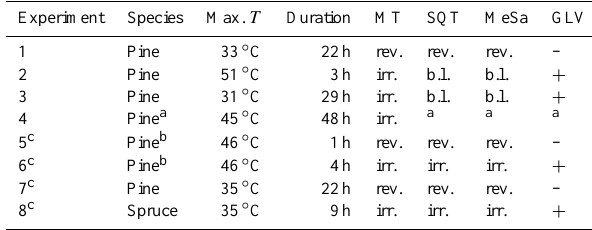
Table 3. List of experiments investigating impacts of heat on BVOC emissions from conifers and observed effects. “rev”: no irreversible effect observed. “irr”: irreversible effect observed with increases of pool MT emissions and decreases of SQT and MeSa emissions; “b.l.”=below detection limit; “ + ” induced GLV emissions during the thermal stress; “ − ” GLV emissions not induced by the heat. Experiment Species Max. T